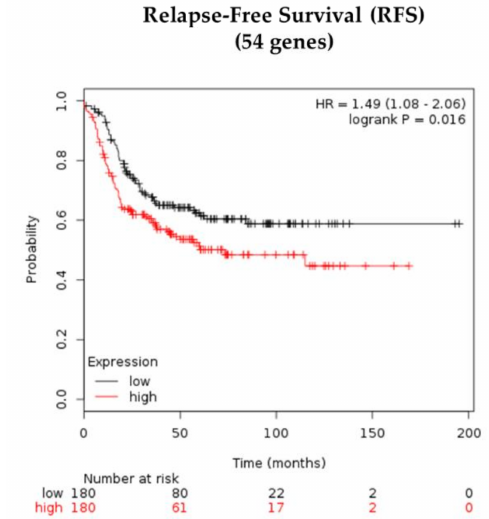
Figure 5. Prognostic value of CTCcl-associated gene signature in patients with basal-like breast cancer (BC), most of whom have TNBC. Fifty-four genes were found to be upregulated in TNBC PDX models with CTCcls. Gene-expression profiles of 360 basal-like BC were each scored with this signature. Kaplan-Meier curve compares distant metastasis-free survival in BC patients with relatively higher signature scoring versus those with lower scoring. Patient data were extracted from publicly available datasets using http: // kmplot.com /